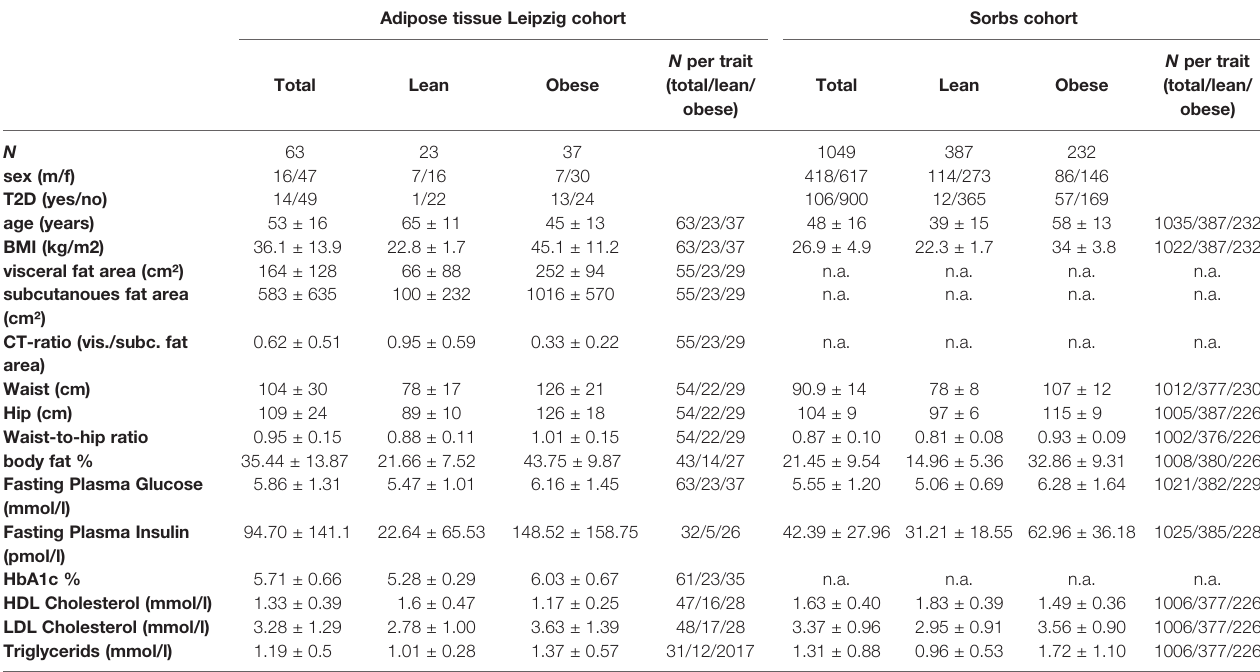
TABLE 1 | Main characteristics of the study